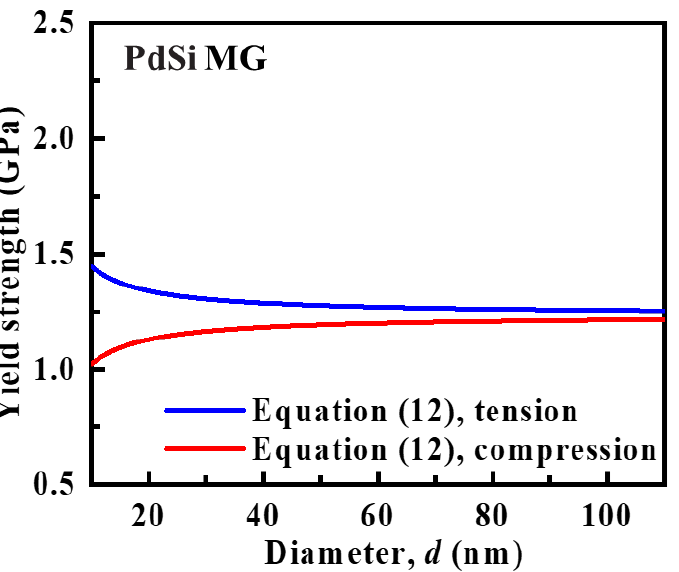
Figure 5. Yield strengths under uniaxial tension and compression as a function of sample diameter for the nano-sized MGs.